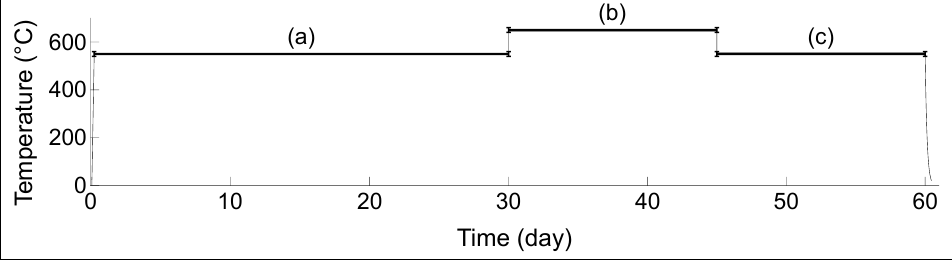
Figure 6. Heating curve for long-term performance: ( a ) one month at 550 ◦ C, ( b ) 14 days at 650 ◦ C, ( c ) 14 days at 550 ◦